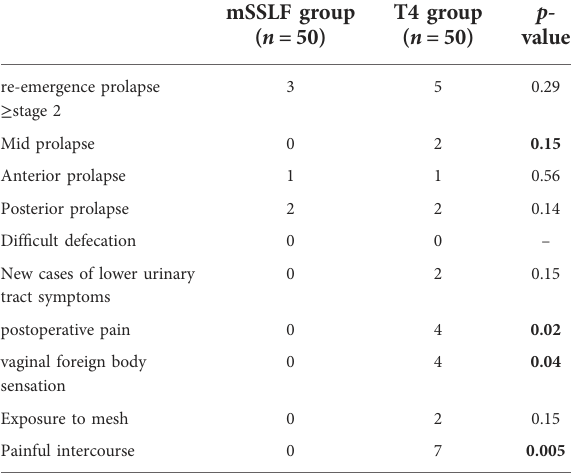
TABLE 5 Postoperative complications.